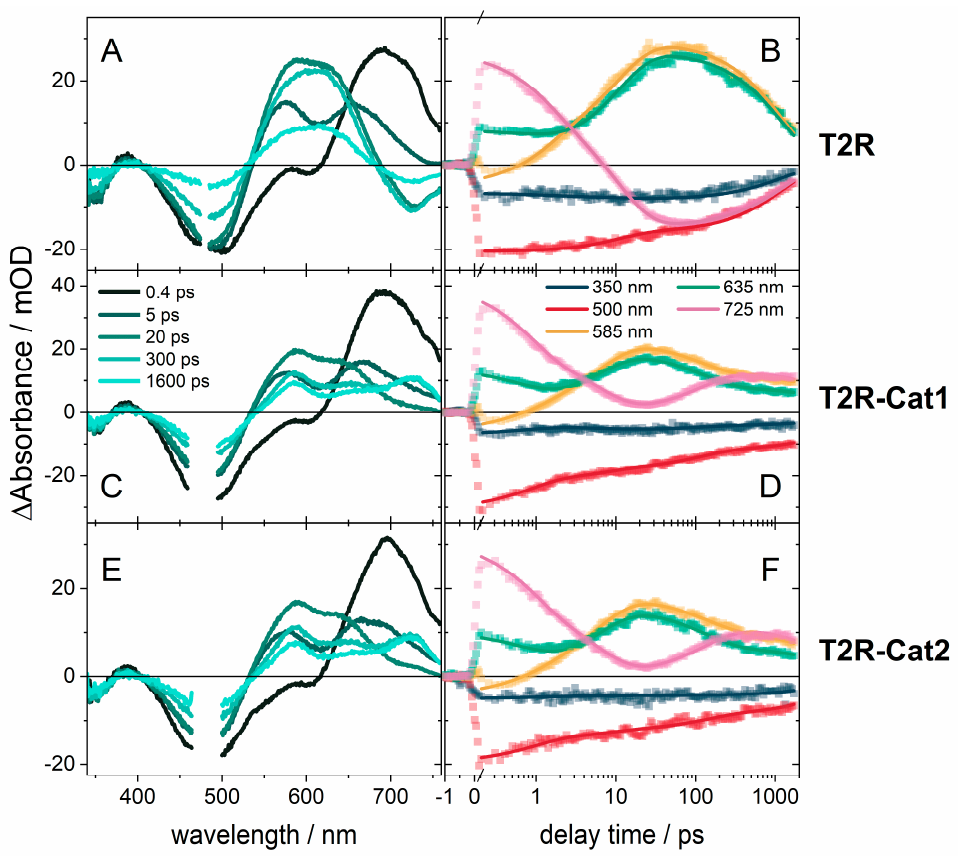
Figure 3. TA spectra at different pump-probe delays ( A , C , E ) and kinetic traces ( B , D , F ) of T2R ( A , B ), T2R-Cat1 ( C , D ) and T2R-Cat2 ( E , F ) in MeOH after excitation at 480 nm. The solid lines in the kinetic traces are fits of the experimental data to the models presented in Figure 4.